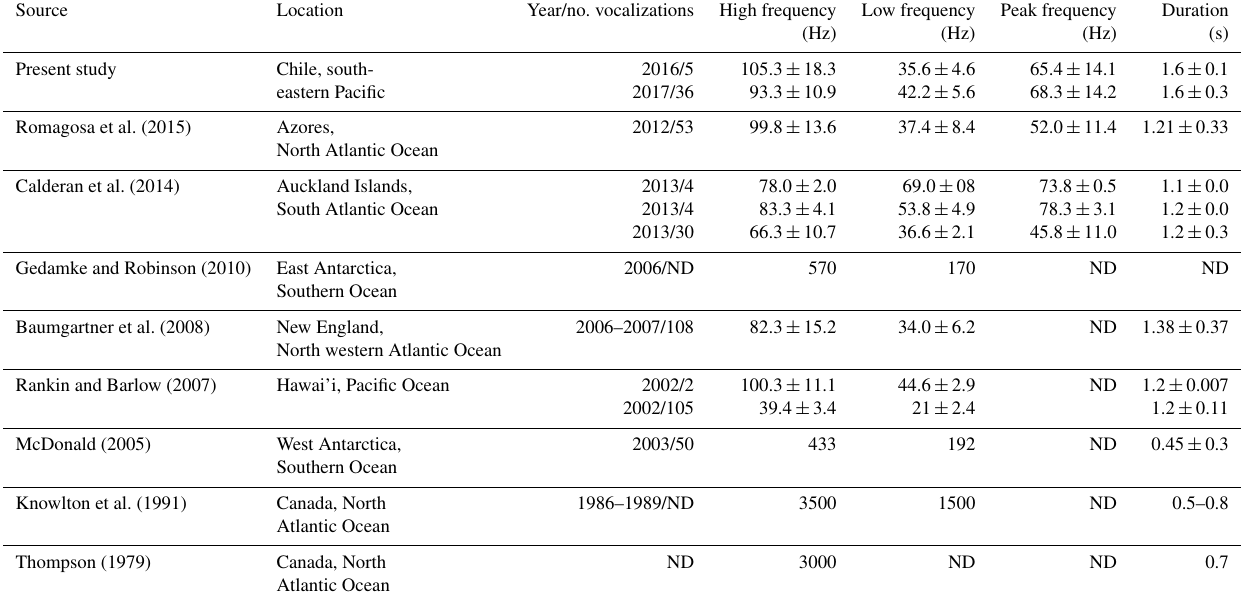
Table 2. Comparison of the frequency and timing of recorded calls of sei whales in the present study with studies in other areas. Values are mean value ± standard deviation. ND: no data (the study did not include that